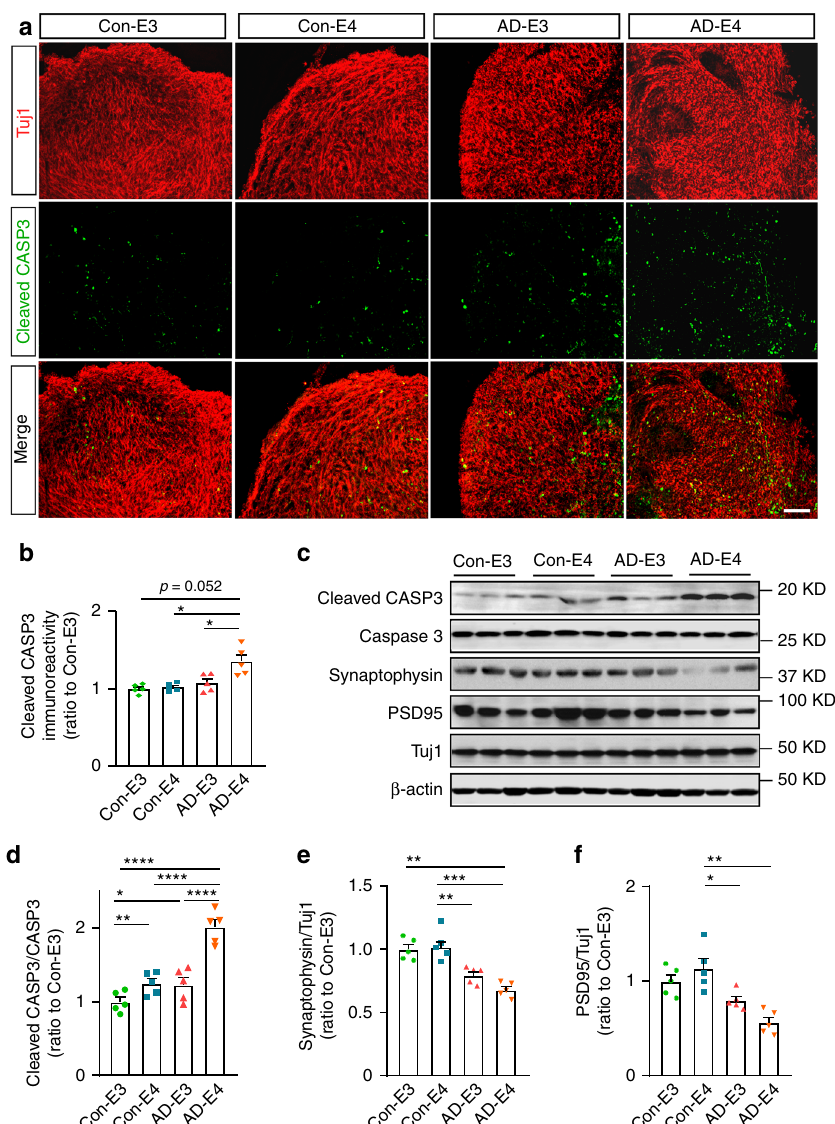
Fig. 2 APOE4 enhances apoptosis and synaptic loss in cerebral organoids from AD patients. cerebral organoids were subjected to immunostaining and western blotting at week 12. a Representative images and quanti fi cation of cellular apoptosis evaluated by immunostaining of cleaved CASP3. Scale bar: 100 μ m. b Cleaved CASP3 immunoreactivities were quanti fi ed from 5 cerebral organoids per line, and the averaged values were compared among the groups ( APOE4: p = 0.032, AD: p = 0.0569, APOE4 x AD: p = 0.018, Con-E3 vs. AD-E4: p = 0.0523, Con-E4 vs. AD-E4: p = 0.0112, AD-E3 vs. AD-E4: p = 0.014). All data are expressed as mean ± SEM ( N = 5). c – f Cleaved CASP3, CASP3, synaptophysin, PSD95, and Tuj1 levels in the lysates of 4 – 5 cerebral organoids per line were analyzed by western blotting and quanti fi ed. All data are expressed as mean ± SEM ( N = 5). d Cleaved CASP3 levels were normalized to total CASP3 levels and compared among groups ( APOE4: p < 0.0001, AD: p < 0.0001, APOE4 x AD: p = 0.0020, Con-E3 vs. Con-E4: p